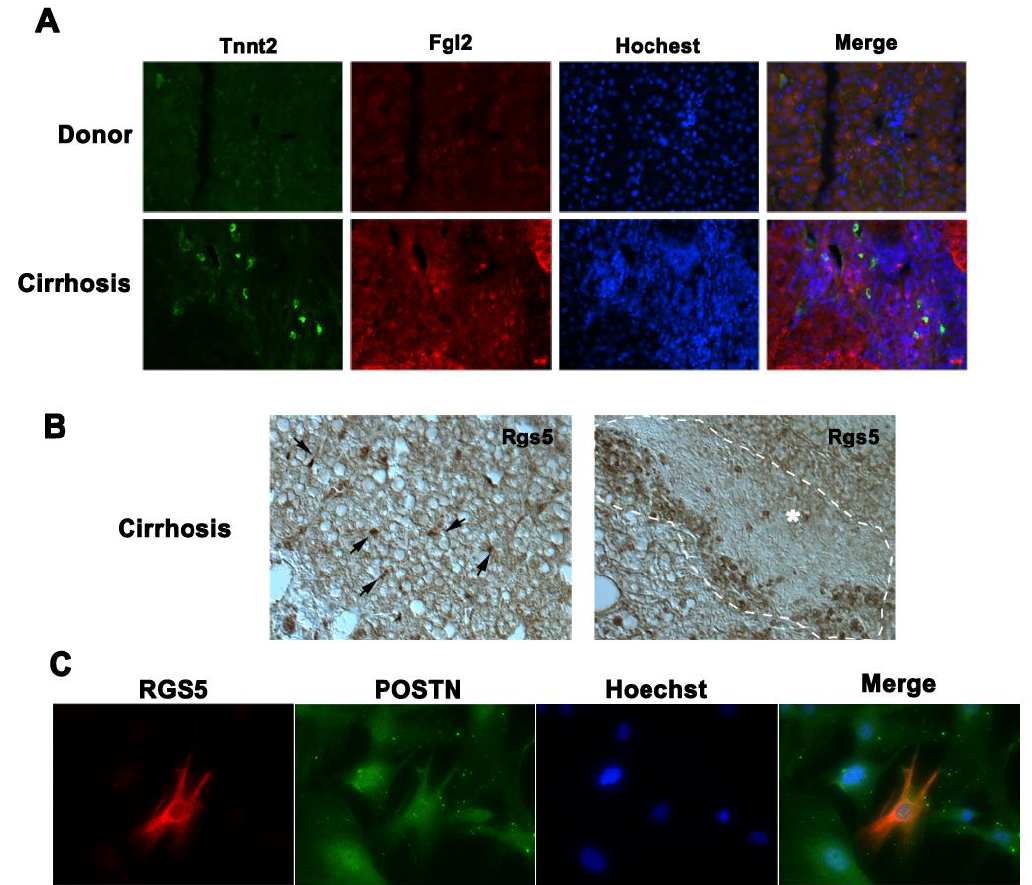
Figure 7. The analysis of heterogeneity of human HSCs in cirrhotic liver. ( A ) Co-Immunofluorescent staining of Tnnt2 and Fgl2 in control (Ctr) and cirrhotic human liver (200×). ( B ) Immunohistochemistry staining of Rgs5 in cirrhotic liver. Left panel shows interstitial Rgs5 positive HSCs (arrows) and right panel shows that Rgs5 positive signal detected in portion of activated HSCs in fibrotic area (within the dash line circle) (200×). ( C ) Co-Immunofluorescent staining of Rgs5 and Postn in fresh isolated human HSCs from cirrhotic liver (400×).